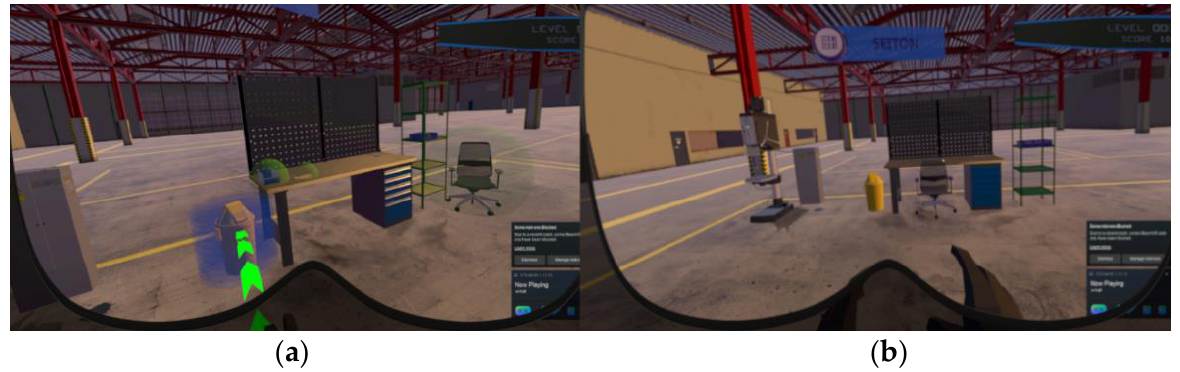
Figure 5. Level 2 ( a ) storing objects in the right place; ( b ) correct arrangement.